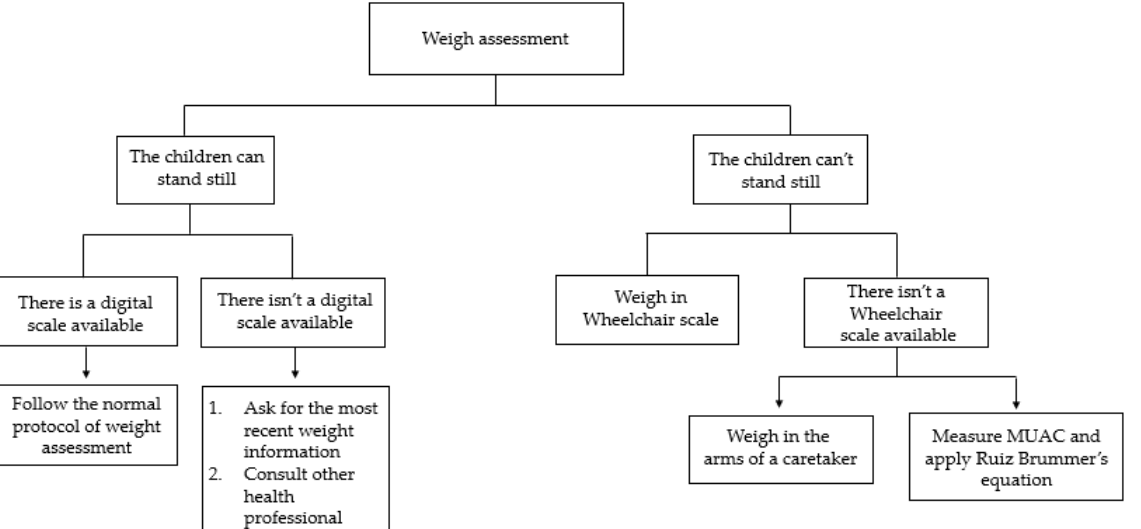
Figure 1. Weight assessment using conventional and alternative methods.